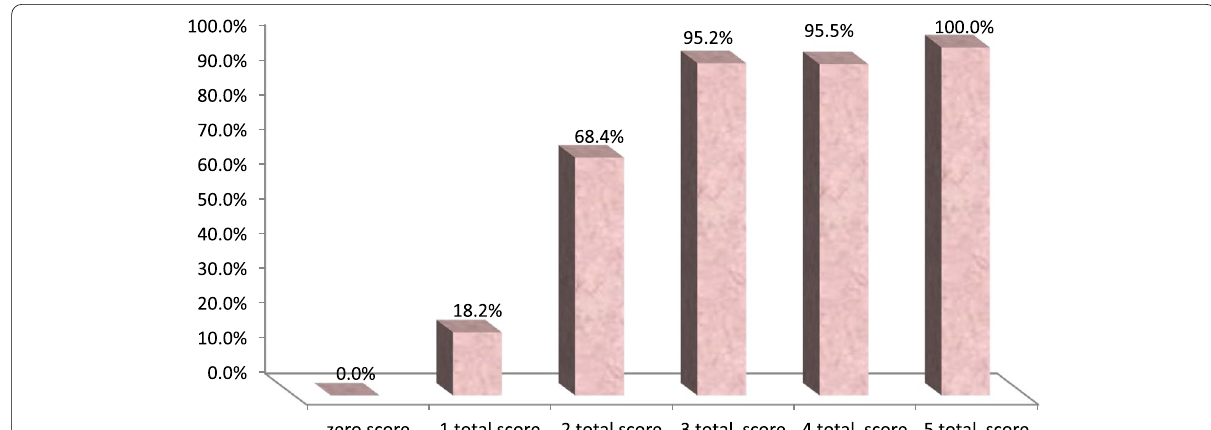
Fig. 3 The percent of adverse pregnancy outcomes and the risk score